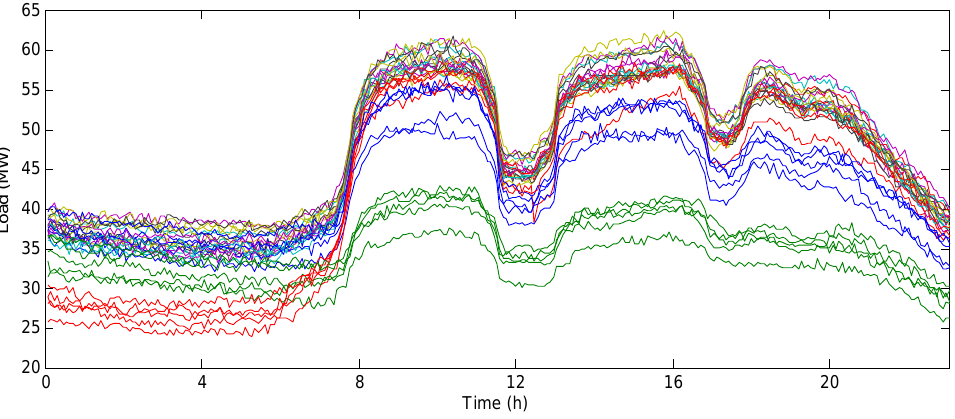
Figure 2. Load profiles of Biling Substation in Shenzhen in March